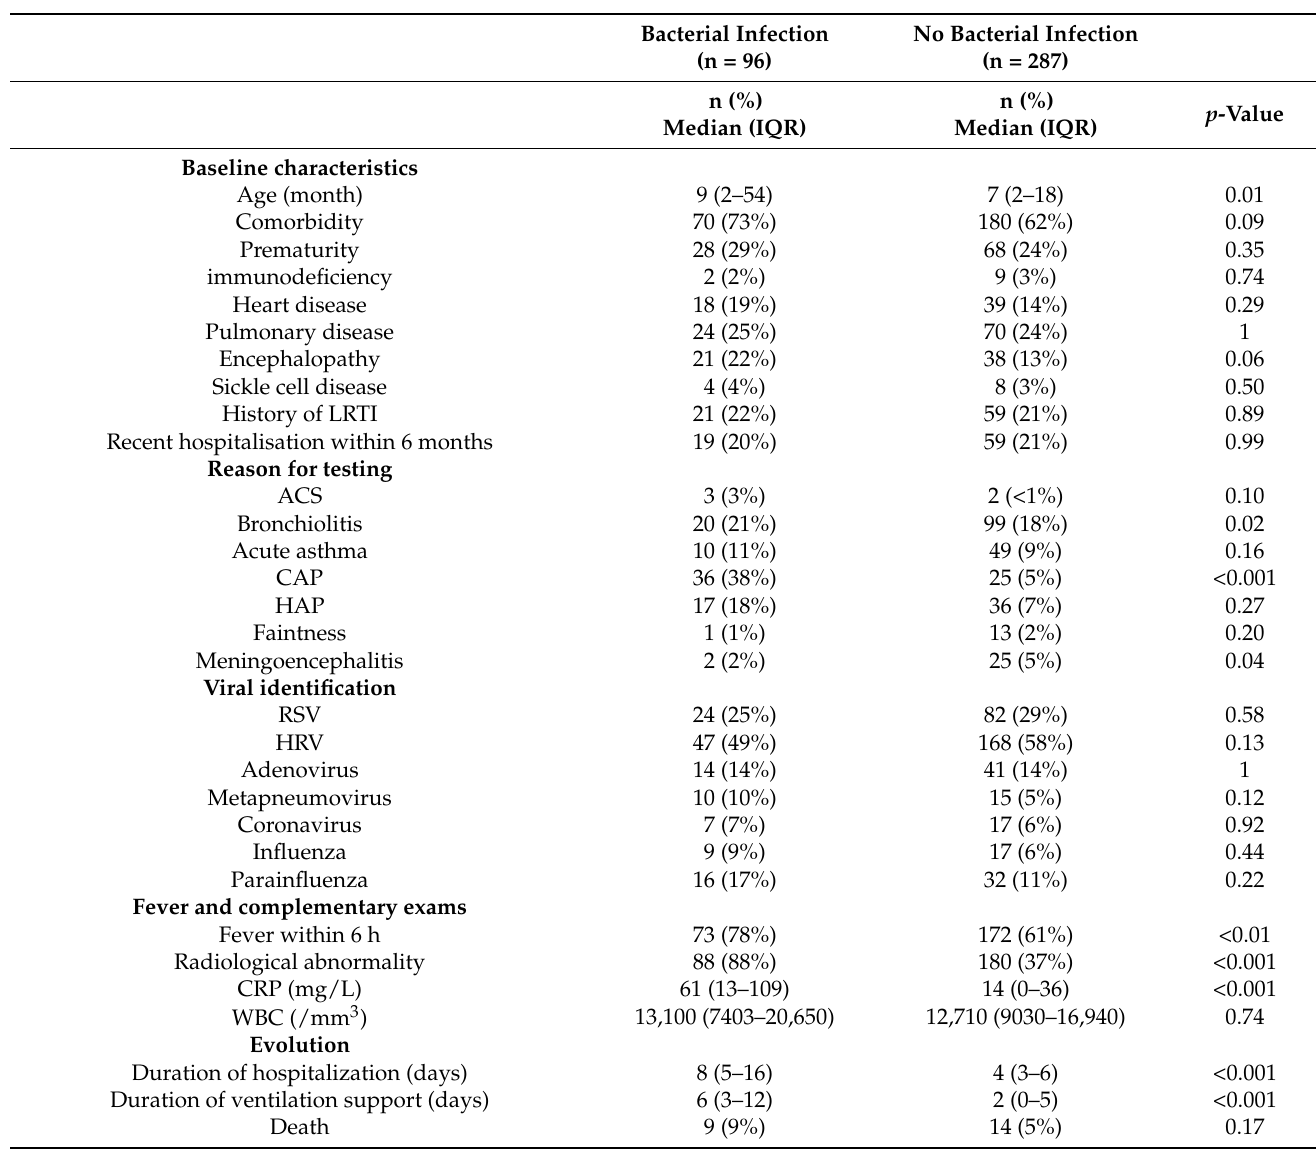
Table 3. Comparison of patient characteristics with or without bacterial infection in children with documented viral infection on FilmArray ® Respiratory Panel